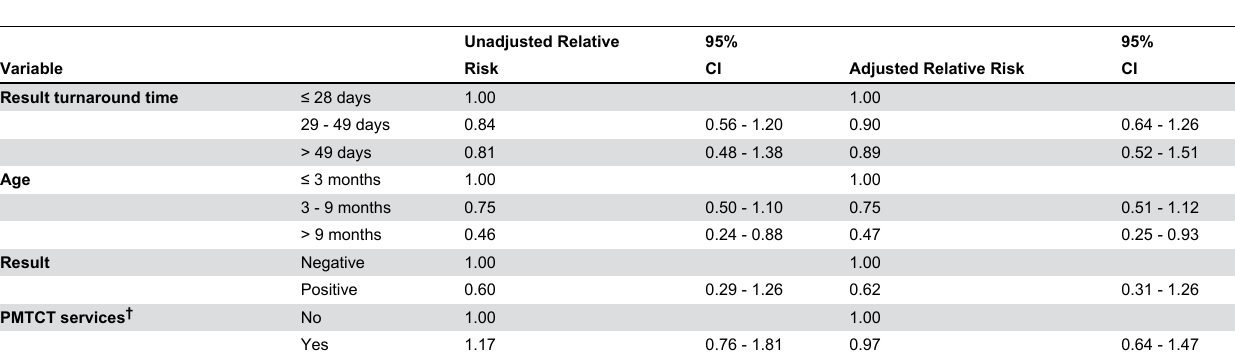
Table 4. Unadjusted and adjusted analysis for result receipt at the Level Four Health Center.